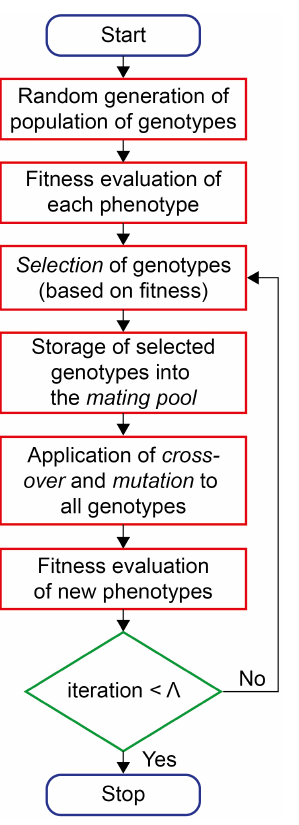
Figure 2. Scheme of the adopted genetic